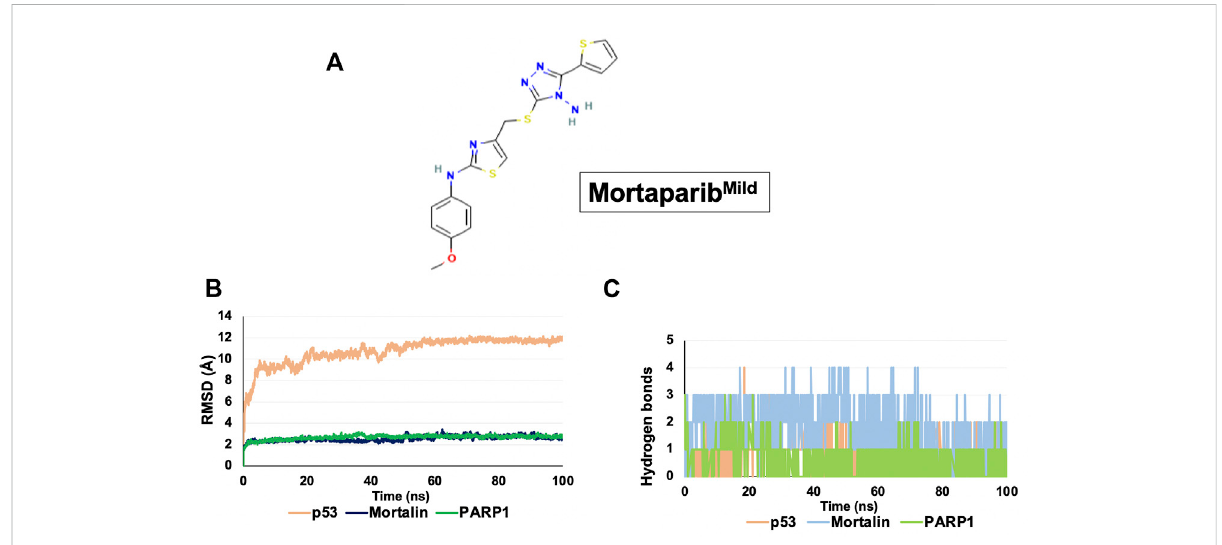
FIGURE 1 Structure and binding dynamics of Mortaparib Mild with target proteins. (A) Molecular structure of Mortaparib Mild . (B) RMSD plot of Mortaparib Mild interaction with p53, mortalin, and PARP1. (C) Hydrogen bond plot of Mortaparib Mild interaction with p53, mortalin, and